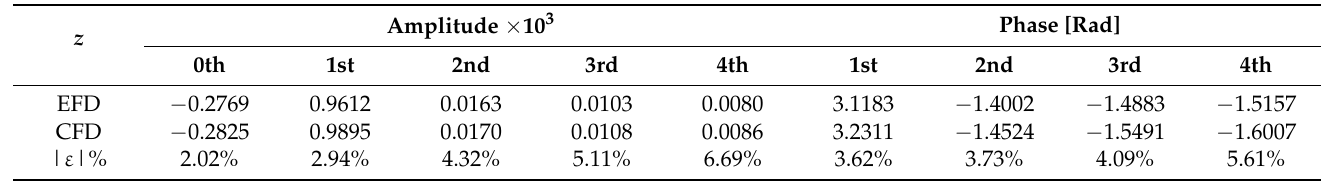
Table 11. Harmonic amplitudes and phases of heave ( z ) for the FRxz ϕθ bow waves scenario.